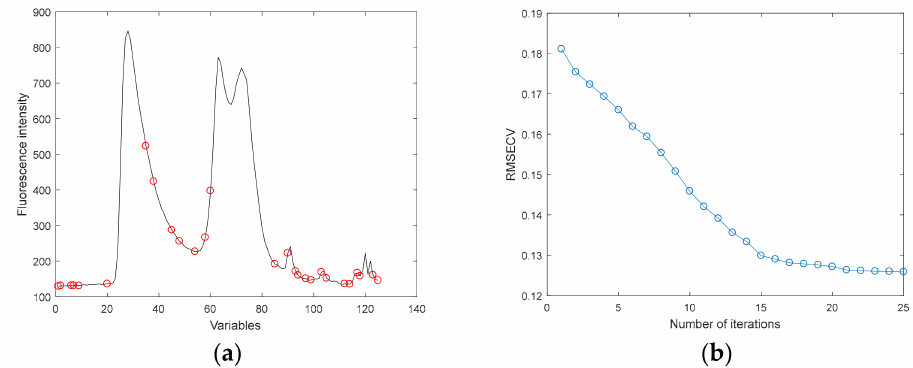
Figure 13. The extraction process of IVMR-VISSA: ( a ) distribution of effective variables; ( b ) the curve of RMSECV.